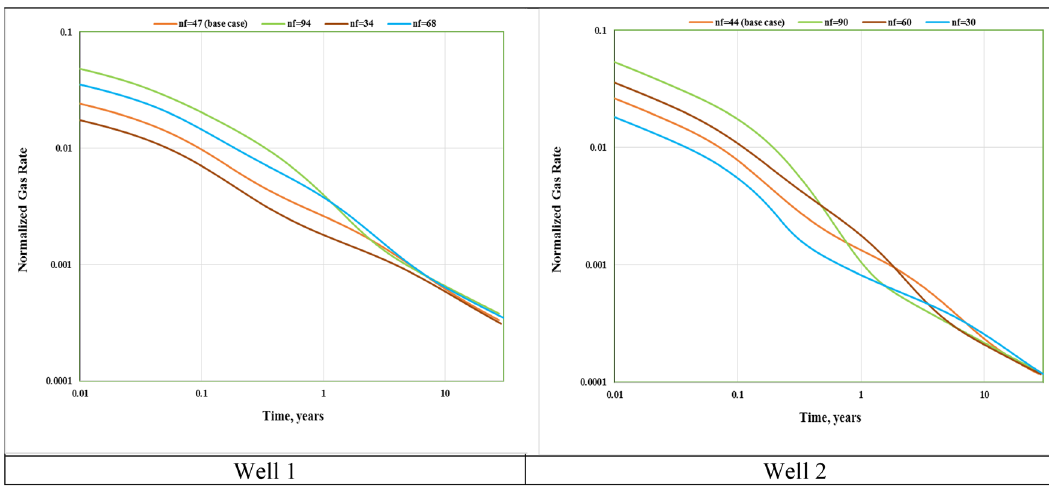
Fig. 9 Fracture number